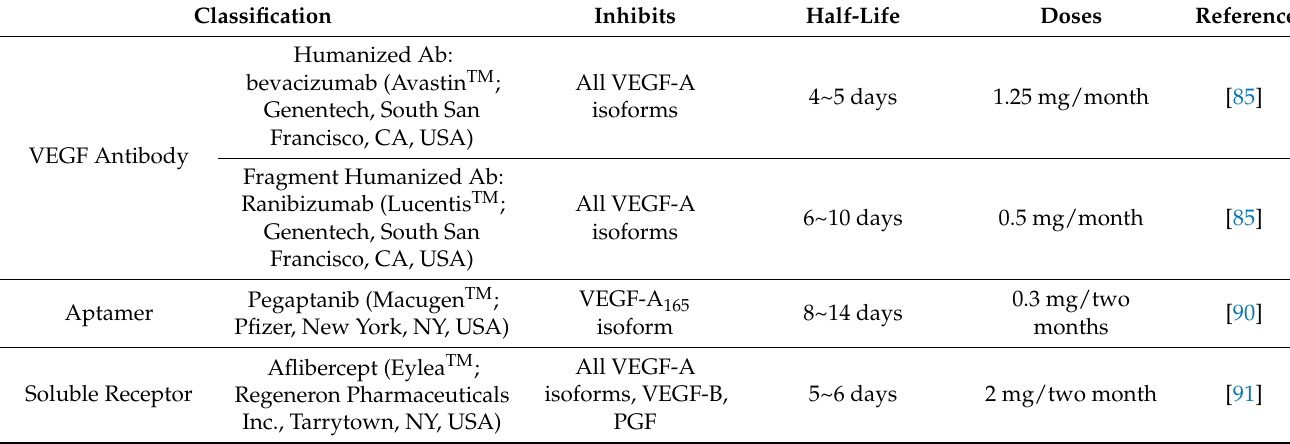
trap), such as aflibercept (Eylea TM ), they cannot serve an angiogenesis function in the vascular Figure 3. Anti-inflammatory pathway caused by corticosteroid drugs and nonsteroidal anti-inflam- matory drugs (NSAIDs). Corticosteroid drugs inhibit the formation of arachidonic acid by causing plasma membrane breakage, which is caused by phospholipase A 2 . On the other hand, nonsteroidal VEGF’s binding, the CNV of VEGF receptors cannot occur. anti-inflammatory drugs (NSAIDs) only control arachidonic acid and prostaglandins through cy- process after VEGF’s binding, the CNV of VEGF receptors cannot occur. clooxygenase 1 or 2 (COX-1 or -2). Table 4. Summary of anti-inflammatory drugs for AMD treatment. Table 5. Summary of the currently used anti-vascular endothelial growth factor (anti-VEGF) drugs for AMD treatment. Classification